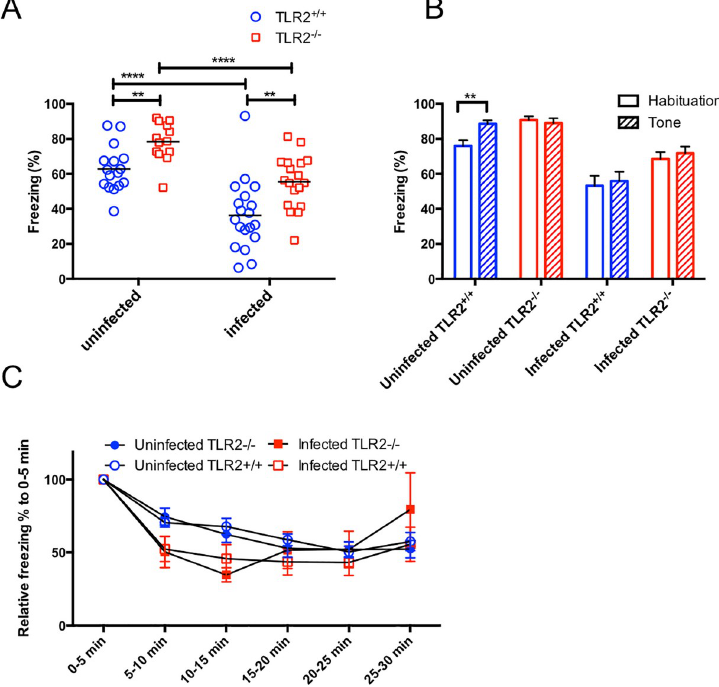
Fig 3. Effects of T . gondii infection on fear memory consolidation in mice. The ordinate shows the percentage of time spent freezing. (A) Contextual conditioned freezing time. Significant differences among the four groups were analyzed by a two-way ANOVA followed by t tests ( �� , p < 0.01; ��� , p < 0.001; ���� , p < 0.0001), significant main effects are shown for TLR2 deficiency [ F (1,62) = 20.06, p < 0.0001] and T . gondii infection [ F (1,62) = 40.58, p < 0.0001]. The interaction between T . gondii infection and TLR2 deficiency was not statistically significant. (B) Tone-conditioned freezing time. Significant differences between habituation and tone sessions were determined by unpaired t tests ( �� p < 0.01). (C) Time course for fear extinction as revealed by the decreased freezing response in the extinction test. Statistical analysis between experimental group pairs including uninfected TLR2 +/+ mice and uninfected TLR2 -/- mice, uninfected TLR2 +/+ mice and infected TLR2 +/+ mice, and uninfected TLR2 -/- mice and infected TLR2 -/- mice were performed by a two-way ANOVA but no statistically significant main effects or interactions were observed. The average freezing response percentage across the 5 min intervals in the extinction test was normalized to the first 5 min. Freezing was calculated by dividing the freezing time by the observation times (300 s) in the context test, habituation (180 s), and tone (180 s) during the tone test, and over 5 min for every 5 min interval in the extinction test. Data represent the means ± SEMs. Data are summarized from two independent experiments (uninfected TLR2 +/+ , n = 16; uninfected TLR2 -/- , n = 13; infected TLR2 +/+ , n = 21; infected TLR2 -/- , n = 18).